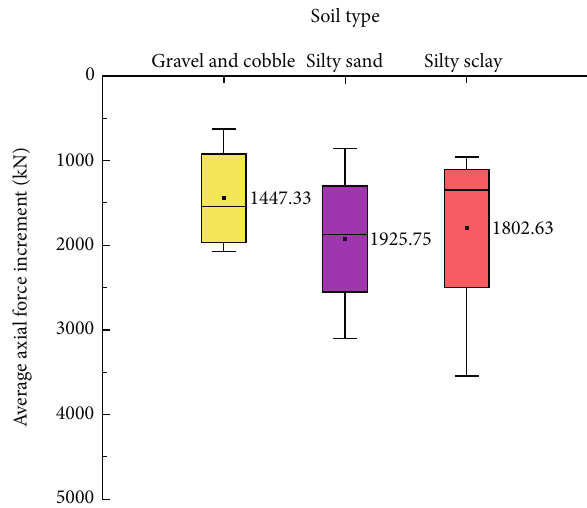
Figure 17: Axial force increment boxplots of the steel pipe column in the soil excavation